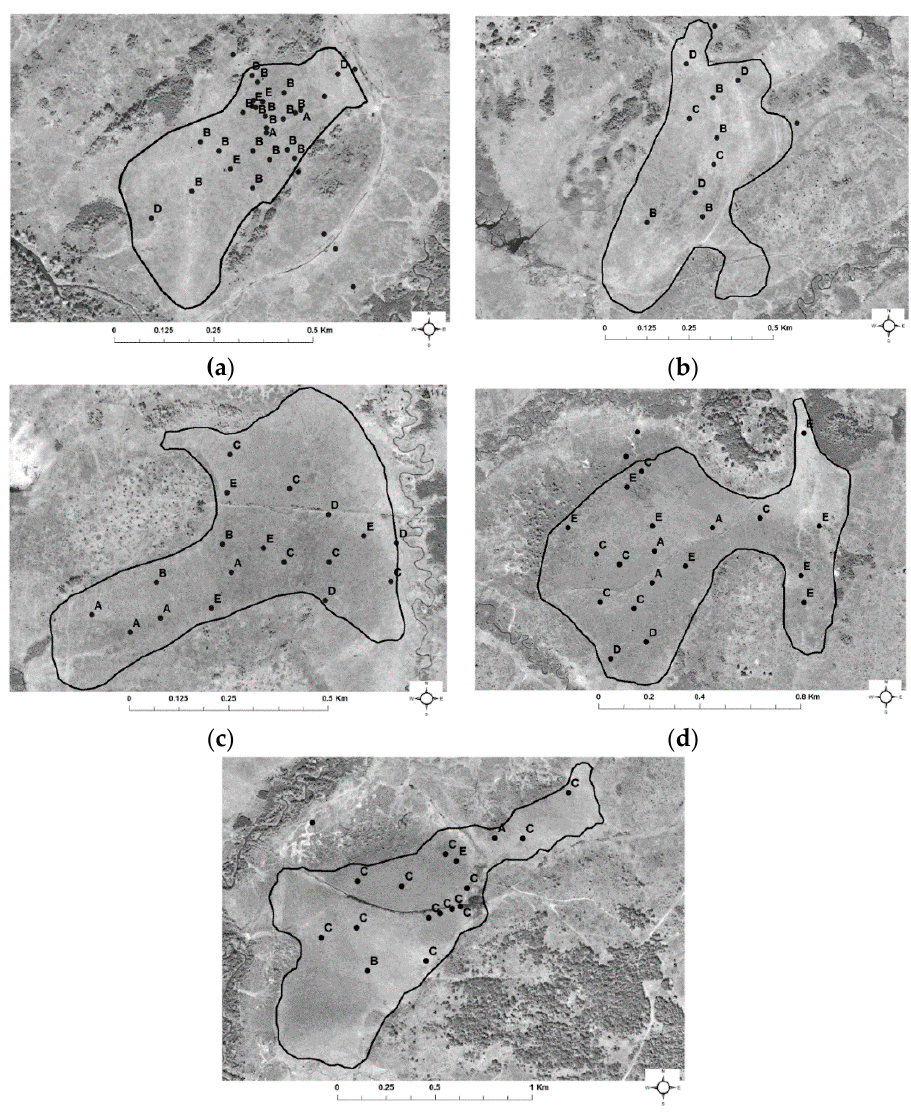
Figure 2. Five CVNWR peatlands with soil cores labeled by categorized catotelm profile type: 2( a ). Peatland 1, 25 cores, dominated by Type B (SH) profiles; 2( b ). Peatland 2, 9 cores, with Type D (S) profiles in shallow areas; 2( c ). Peatland 3, 19 cores, including all five soil types; 2( d ). Peatland 4, 19 cores, including Type C (HSH) profiles clustered at the thickest peat, surrounded by Type E (HS) profiles, and a cluster of Type A (H) profiles; 2( e ). Peatland 5, 16 cores, dominated by Type C (HSH) profiles. S and H represent Sapric (highly decomposed) and Hemic (moderately decomposed). Soil core locations were chosen according to the “free survey” method of sampling soils, which involves the individual development and application of soil–landscape con- cepts based on the observation that soils vary repetitively and predictably with the ge- omorphology, topography, and similar information [70]. The locations of cores were representative of the immediately surrounding terrain. Small-scale hummocks and hollows were avoided, as were the locations of known anthropogenic disturbance.